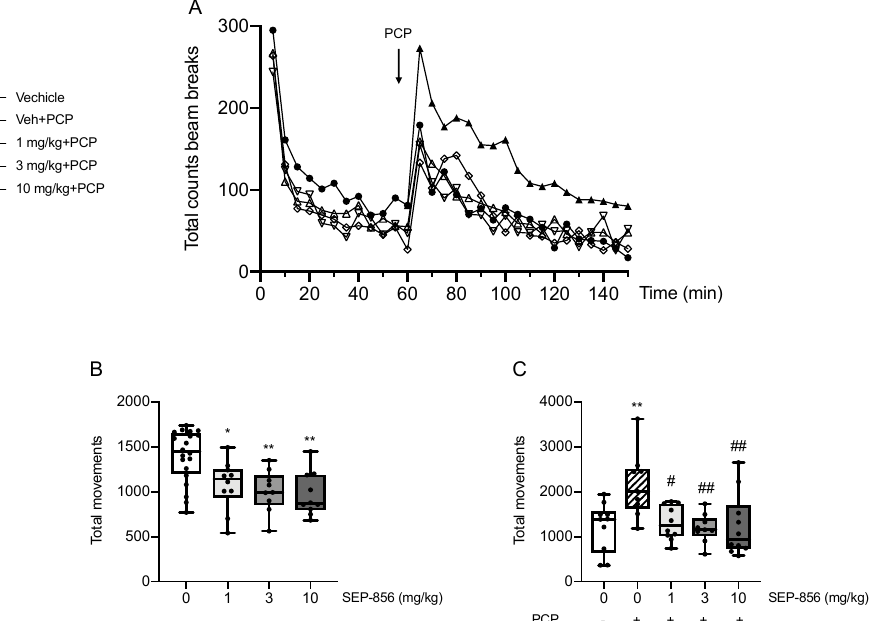
Figure 2. Analysis of total locomotor activity. Total locomotor activity counts over 150 min ( A ). The first 60 min show locomotor activity after treatment with SEP-856 (1, 3 & 10 mg/kg, p.o.) or vehicle. At 60 min rats received acute injection of PCP (2 mg/kg, i.p.) or vehicle, as indicated by the arrow, and locomotor activity was measured for further 90 min. The total activity was measured over the first 60 min ( B ) pretreatment with different doses of SEP-856 (1, 3, 10 mg/kg) and over the 90 min period ( C ) following PCP administration. Data are represented as box-and-whisker plots ( B and C ) of at least nine independent determinations. For each box, the box boundaries indicate the first and third quartiles, the middle line specifies the median and the whiskers represent the lowest and highest values. * p < 0.05, ** p < 0.01 vs. vehicle-treated rats; # p < 0.05, ## p < 0.01 vs. PCP-treated rats (one-way ANOVA followed by Tukey post-hoc